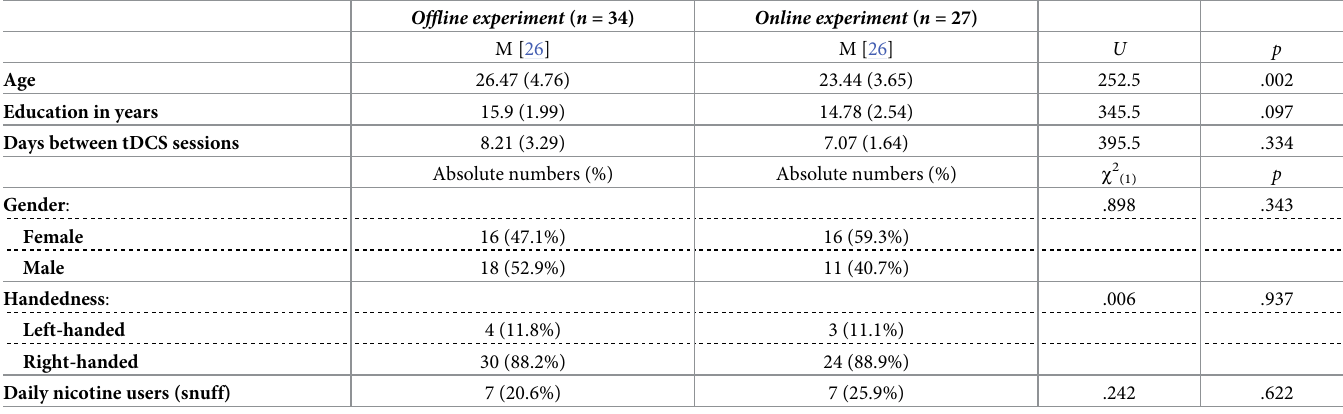
Table 1. Participant characteristics in both